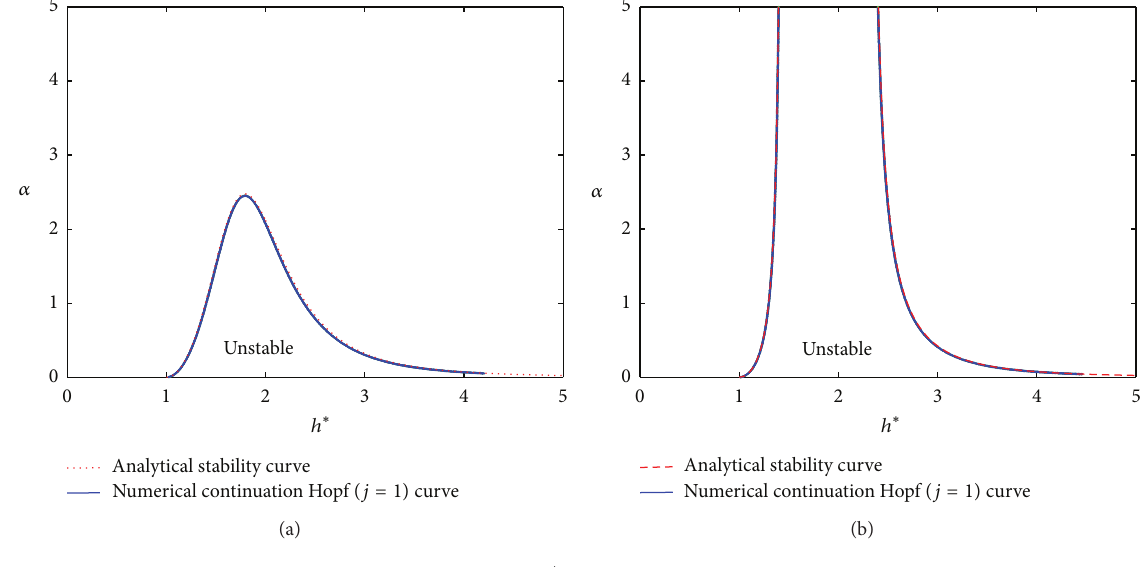
Figure 1: Stability diagram in the (ℎ ∗ ,𝛼) plane for (a) 𝜏 = 0.2 and for (b) 𝜏 = 1